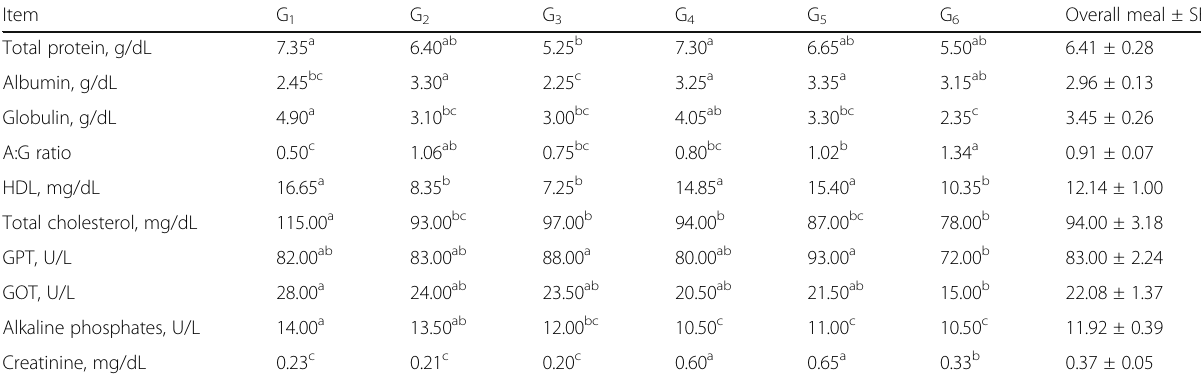
Table 5 Effect of dietary treatments on some blood plasma constituents of laying hens Item G